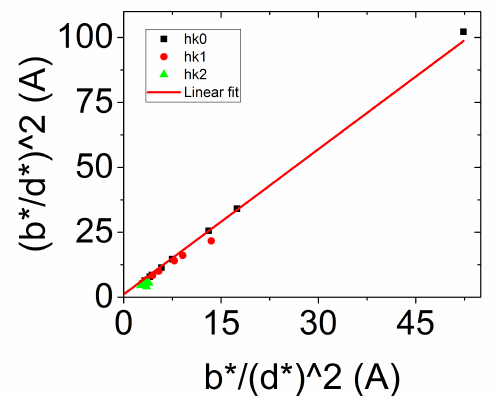
Figure 6. Halder-Wagner plot for a typical